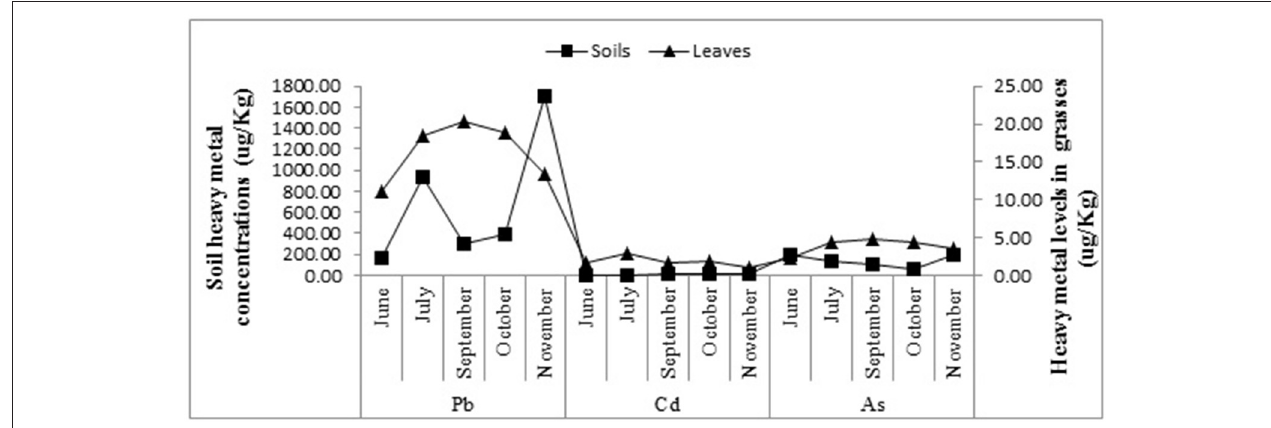
FIGURE 4 | Relationships for lead, cadmium and arsenic concentrations within the marsh soil and Spartina leaves for the study year 2014.